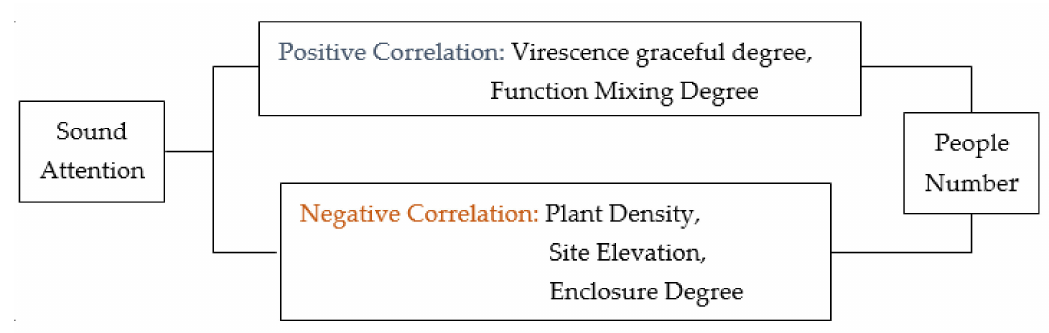
Figure 8. Framework of the “number of people